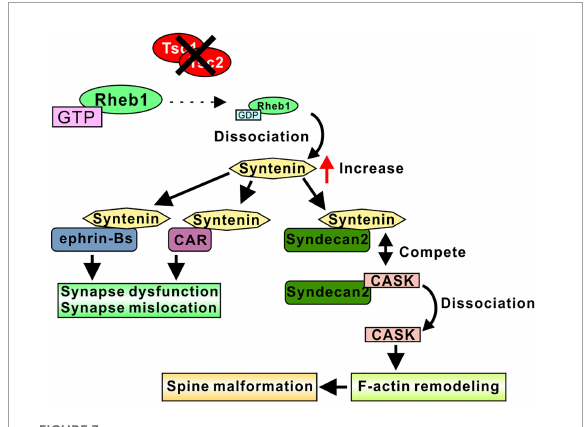
FIGURE3 Syntenin-mediated spine and synapse regulation in TSC